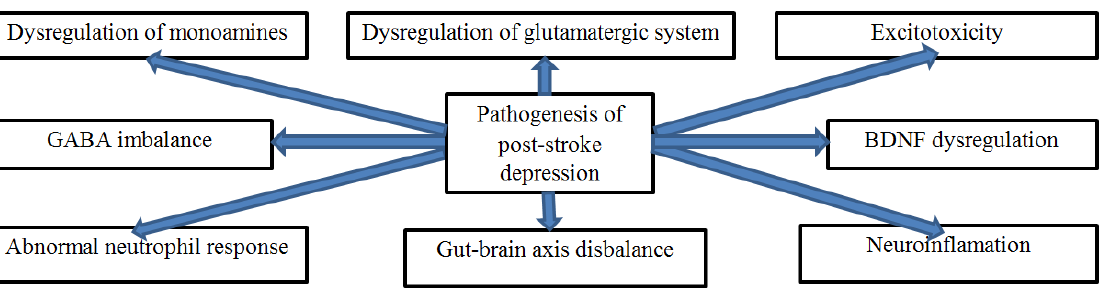
Figure 1. Schematic of the pathogenesis of PSD. The multimodal pathogenesis of PSD can be best understood by examining the roles of the monoamine system, glutamatergic system, excitotoxicity, gut-brain axis, neuroinflammation, and abnormal neutrophilic response.